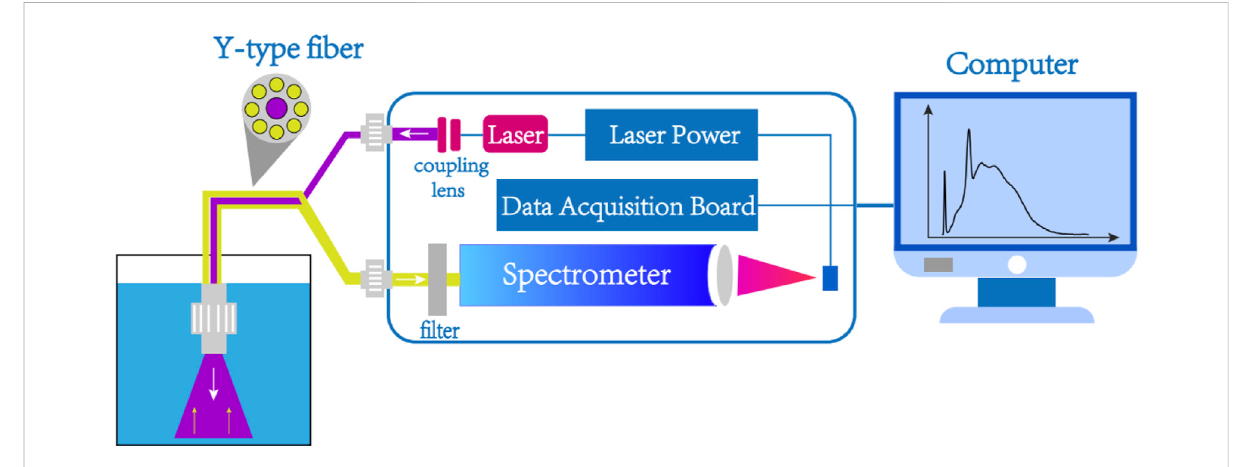
FIGURE 2 Experimental setup of the COD measurement.